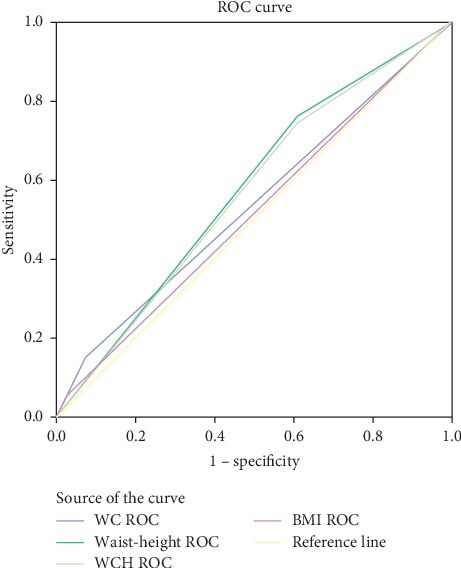
Receiver operating characteristic curve of body mass index (BMI), waist circumference (WC), waist-hip ratio (WHR), waist-to-height ratio (WHtR), and waist-to-square height ratio (WHt2R) to diabetes mellitus in male.